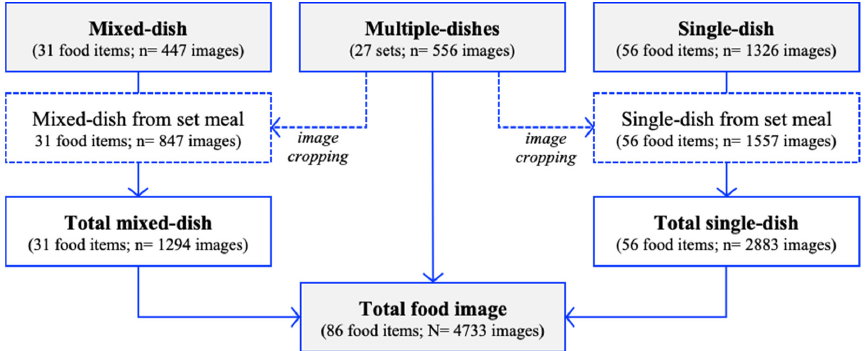
Figure 2. The collection process of data samples using local food image dataset.